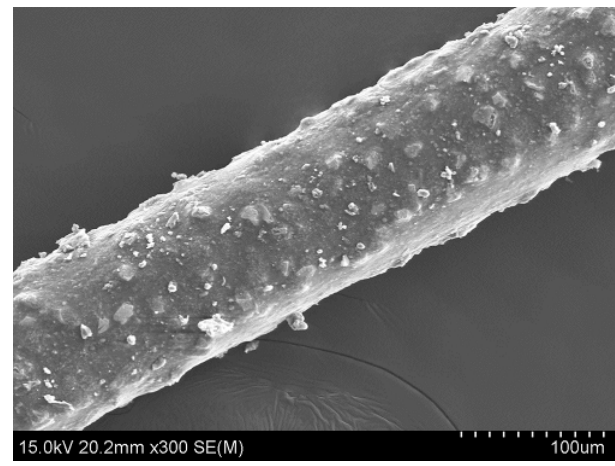
Figure 2. The morphology of resin bonded diamond wire saw.